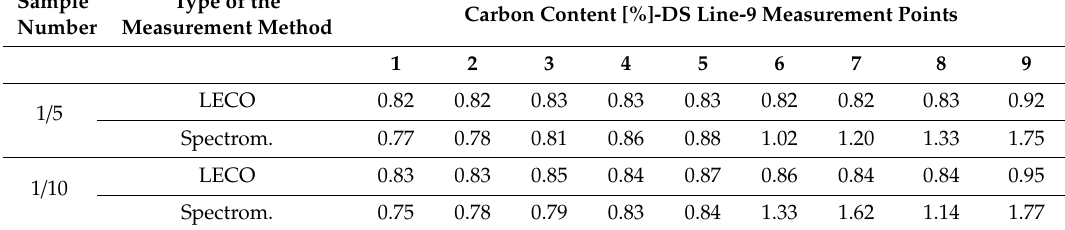
Figure 5. Example of sample taken from a billet cross-section with marked points for carbon content measurement. Table 1. Summary of analyses of carbon content in random samples, performed with a LECO analyser and with a spark spectrometer (Spectrom.) for a casting speed of 1.8 m / min (Heat no.1).